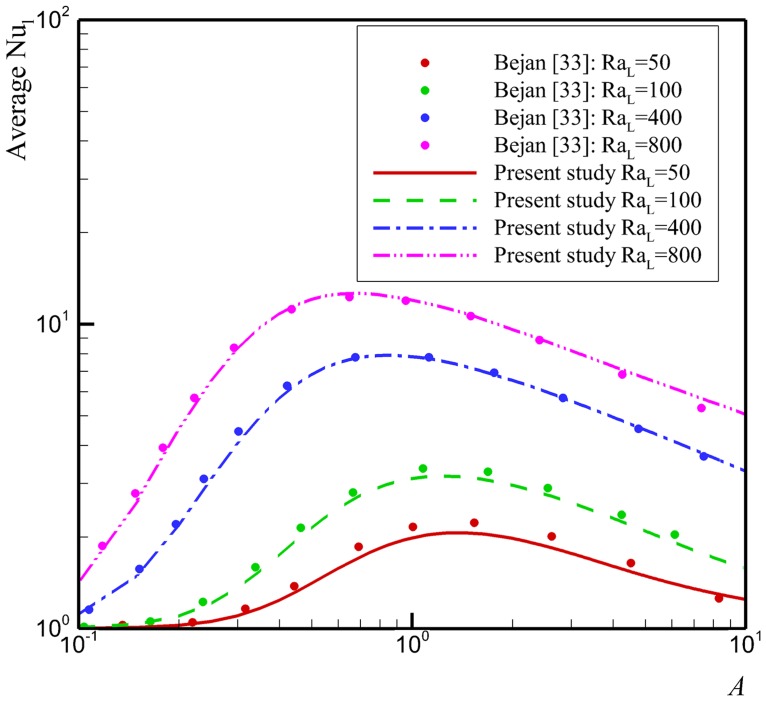
Comparison with Bejan [33] in the case of rectangular enclosure saturated with a pure fluid.